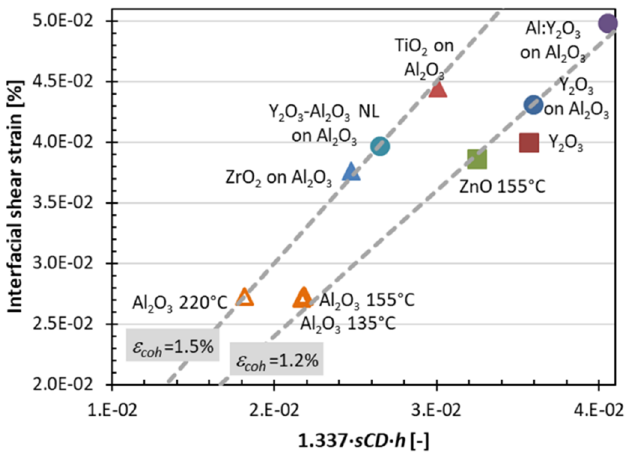
Figure 8. Interfacial shear strains versus the saturated critical crack density ( sCD ) times total film thickness ( h ) for all films on polyimide. Data points along a straight line feature the same cohesive film strain. The error bars were omitted in the graph for clarity and are around 10% to 30% for the interfacial shear strain and 20% for the x-axis; the exact values are listed in Table 2. Table 3. Summary of fracture data of Al 2 O 3 ALD films and their residual strains ε r = ε i + ε T on polyimide. Young’s modulus E and the film’s intrinsic strains ε i were deduced from Ylivaara